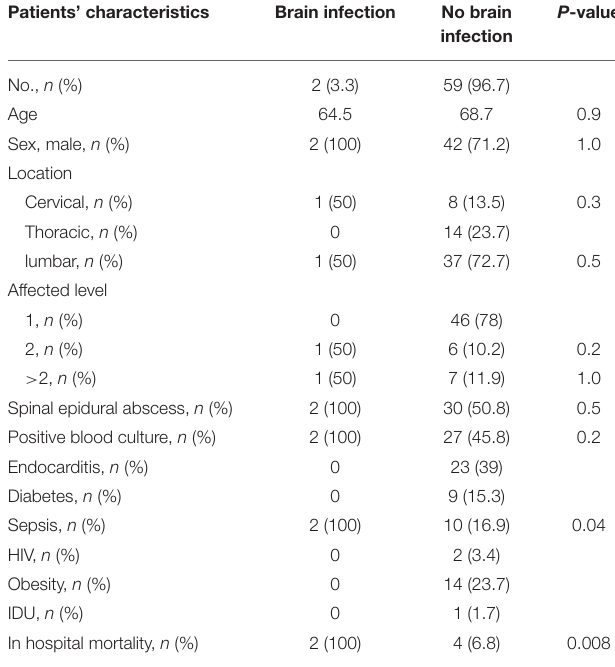
TABLE 1 | Baseline characteristics of patients with spinal infection and brain